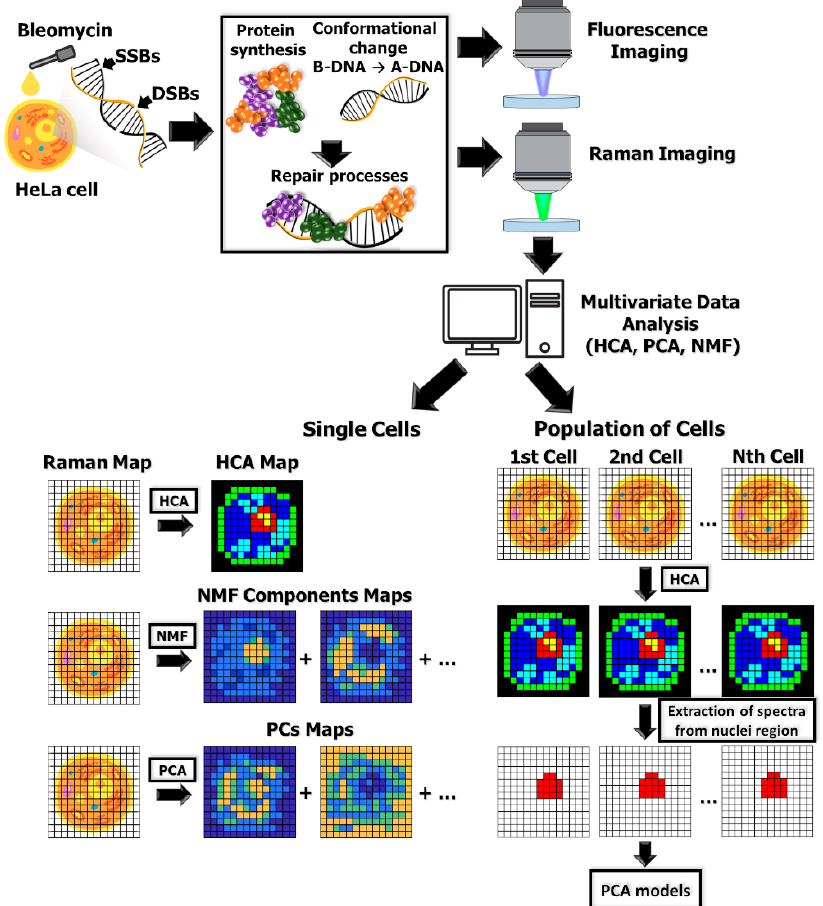
Figure 1. Schematic representation of experimental, analytical and statistical approach in the reported research. Bleomycin-induced DNA damage (SSBs and DSBs) leads to synthesis of repair proteins and DNA conformational change from B-DNA to A-DNA. Biochemical response to DNA damage induction can be observed as characteristic markers in Raman spectra or foci in fluorescence images. Raman images of individual cells were analyzed via HCA, NMF and PCA. As a result, false color maps were obtained. Spectra extracted using HCA algorithm from nucleus area of several control and BLM-treated cells were also analyzed with PCA.